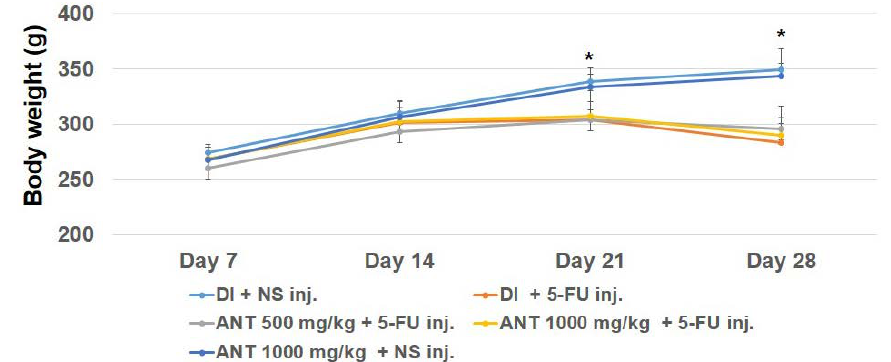
Figure 2. Mean body weight of rats in different groups. Rats were gavage-fed with either deionized water (DI) or ANT-rich extract and injected with normal saline (NS) or 60 mg/kg of 5-fluorouracil (5-FU). Body weight was measured every two days. Data expressed as mean ± S.D. ( n = 6 rats/group), * p < 0.05, vs. rats in the 5-FU treatment groups.